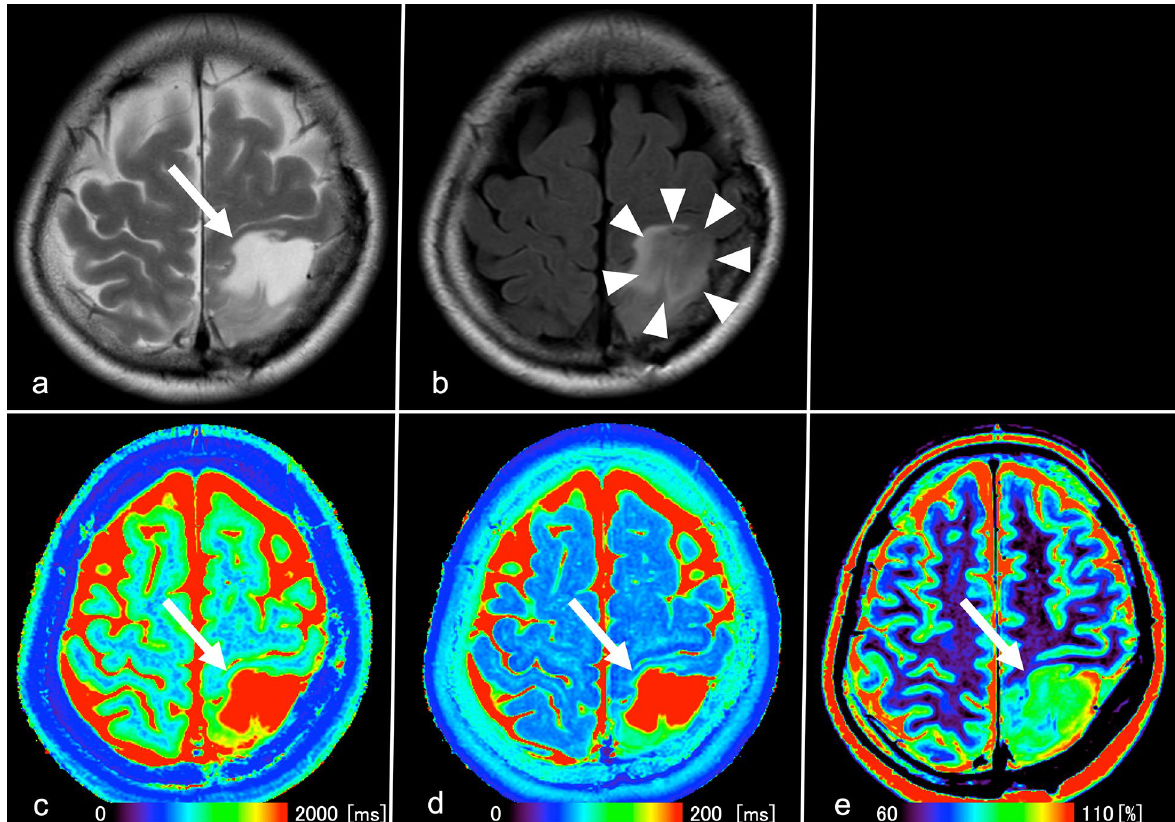
Figure 3. Images from a 49-year-old woman with IDH-mutant diffuse astrocytoma (WHO grade II). ( a ) T2WI shows a heterogeneous T2-prolonged mass in the left parietal lobe (arrow). ( b ) FLAIR shows partial signal suppression, indicating a T2-FLAIR mismatch sign (arrowheads). ( c ), ( d ), ( e ), T1 and T2 relaxation time and proton density (PD) maps derived from SyMRI show T1 (2436 ms*) and T2 (287 ms*) relaxation time prolongations and increased PD (94.9%*) (arrows) in the tumor. *Each value is expressed as the